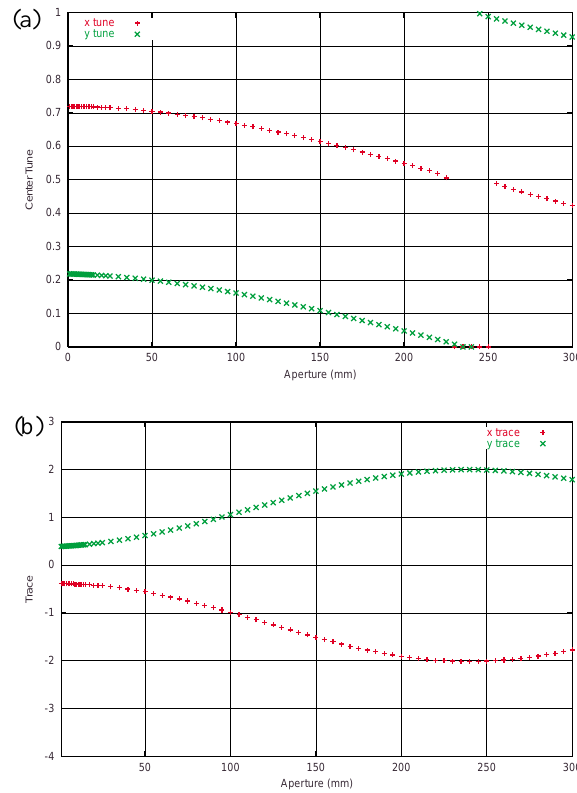
FIG. 5. (Color) (a) Same as Fig. 1 and (b) same as Fig. 2, but without the matching section, where most of the fringe field effects are concentrated.